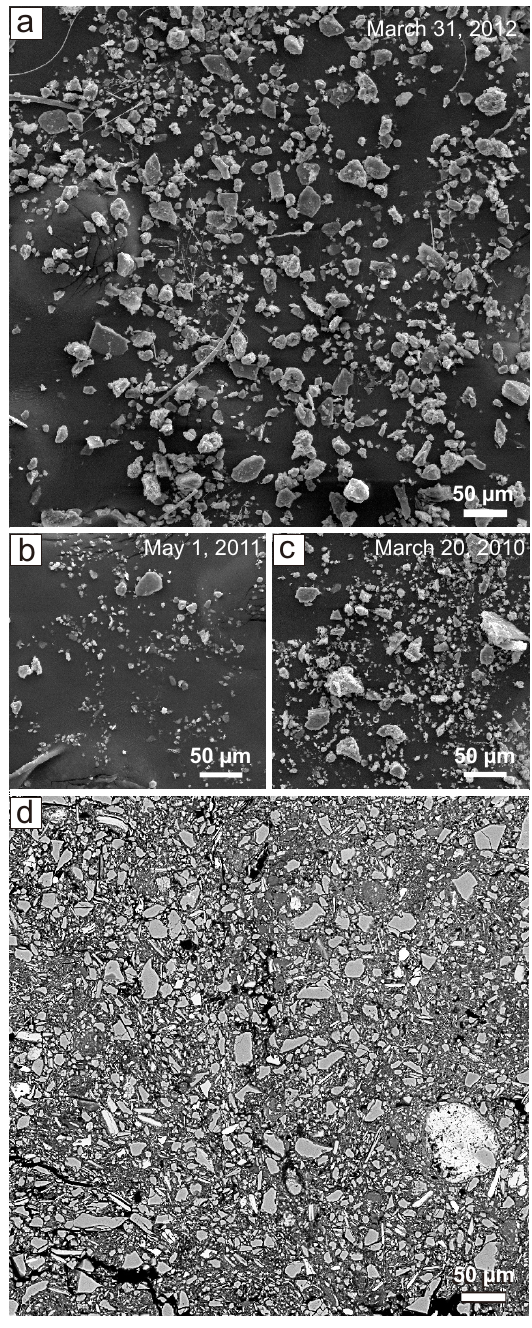
Fig. 2. Scanning electron micrographs of Asian dust particles. (a) Giant Asian dust particles, 31 March 2012, Deokjeok Island. Curved threads are contaminants from borosilicate glass-fiber fil- ter. (b) Asian dust, 1 May 2011, Andong. (c) Asian dust, 20 March 2010, Andong. (d) Back-scattered electron image of the polished, thin section of aeolian sediment from the Jeongok Paleolithic site, showing quartz, K-feldspar, and plagioclase particles (bright gray contrast) in the fine clay matrix (dark gray contrast) with pores (black) impregnated with epoxy